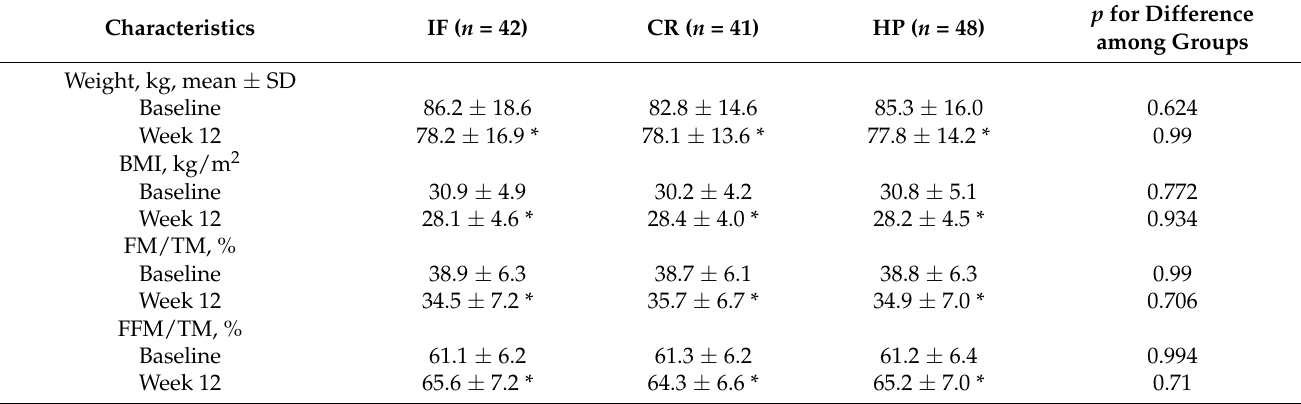
Table 3. Change in study outcomes at baseline and 12